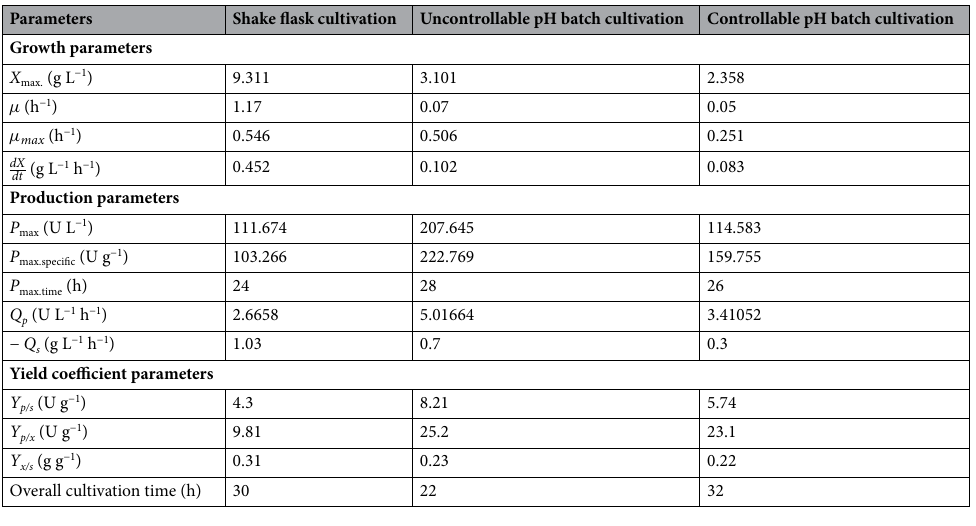
Table 5. Kinetic parameters of cell growth and ACP production by B. haynesii strain ACP1 as affected by dX different cultivation strategies. X max. , maximal cell dry weight; dt , cell growth rate; µ, specific growth rate; P max , maximal ACP production; P max specific , specific productivity; Q p , ACP production rate; Q s , substrate consumption rate; Y p/x , U g −1 of ACP produced per g biomass; Y p/s U g −1 of ACP produced per g